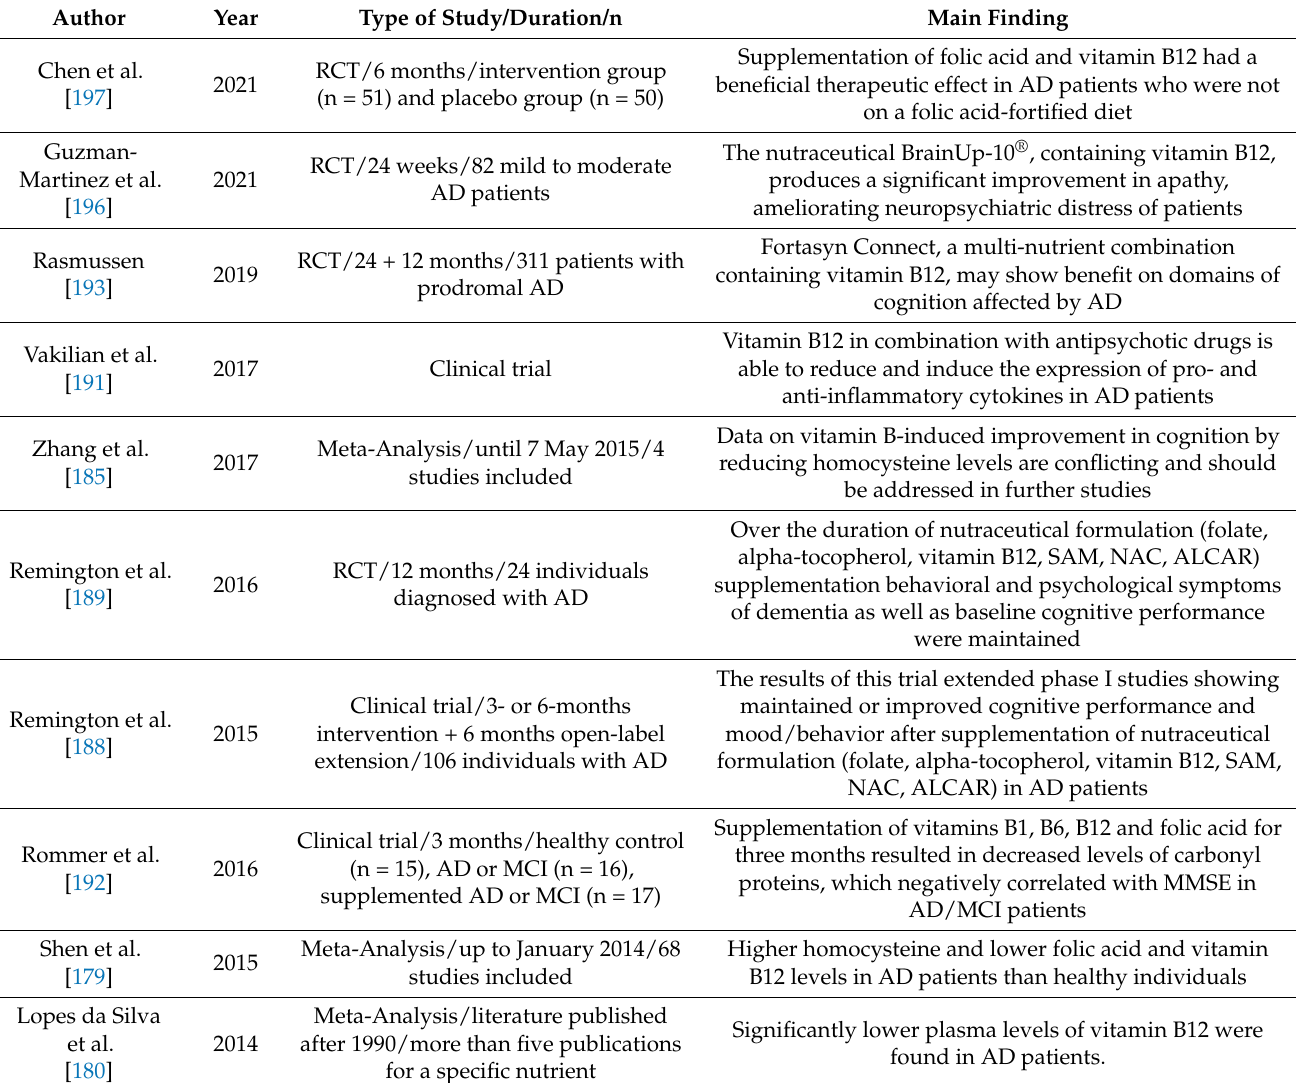
Table 2. Clinical studies dealing with vitamin B12 and Alzheimer’s disease. RCT: